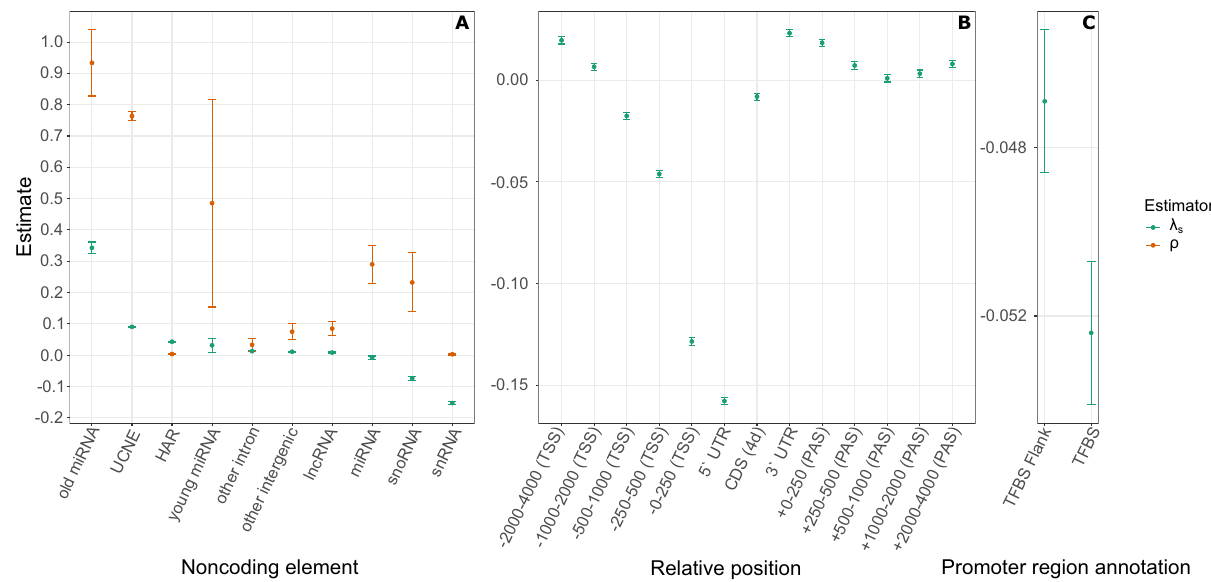
Fig. 3 Measures of purifying selection at annotated noncoding elements and in genomic intervals near protein-coding genes. A Estimates for both ExtRaINSIGHT ( λ s ; teal) and INSIGHT ( ρ ; orange) at noncoding elements ( x -axis). B Estimates of λ s in windows upstream of the transcription start site (TSS) and downstream of the polyadenylation site (PAS) ( x -axis). The 5 0 and 3 0 UTRs are also shown, as are fourfold degenerate (4d) coding sites (CDS). C Estimates of λ s for the extended promoter region (2kb upstream of the TSS) within transcription factor binding sites (TFBS) annotated in the Ensembl Regulatory Build 44 and in the immediate fl anking sequences (10bp on each side). The difference in ( C ) is highly statistically signi fi cant by a two-sided likelihood ratio test based on the ExtRaINSIGHT likelihood model ( p = 2.8 × 10 − 13 ). Error bars are centered at the MLE and indicate one standard error in each direction (see “ Methods ” ). Numbers of elements: A old miRNA: n = 7537; UCNE: n = 1,415,142; HAR: n = 674,492; young miRNA: n = 6285; other intron: n = 971,109,276; other intergenic: n = 1,255,478,347; lncRNA: n = 453,200,392; miRNA: n = 140,681; snoRNA: n = 49,837; snRNA: n = 155,304; B n = 58,496. C n =